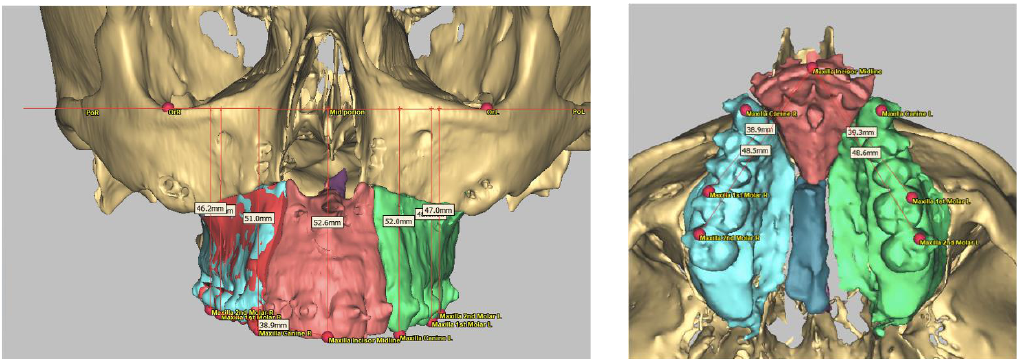
Figure 5. Measures with Frankfort plane and interdental spaces.